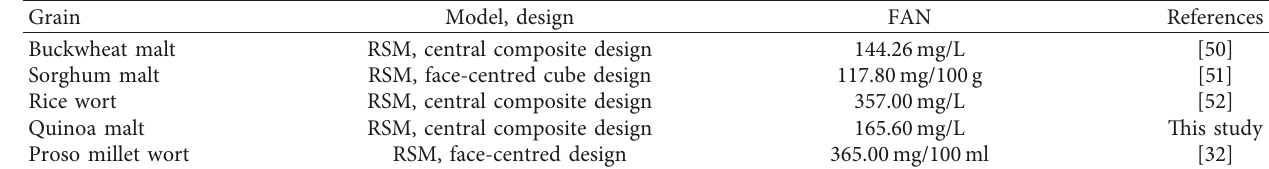
Table 9: Summary of FAN values from malting studies using